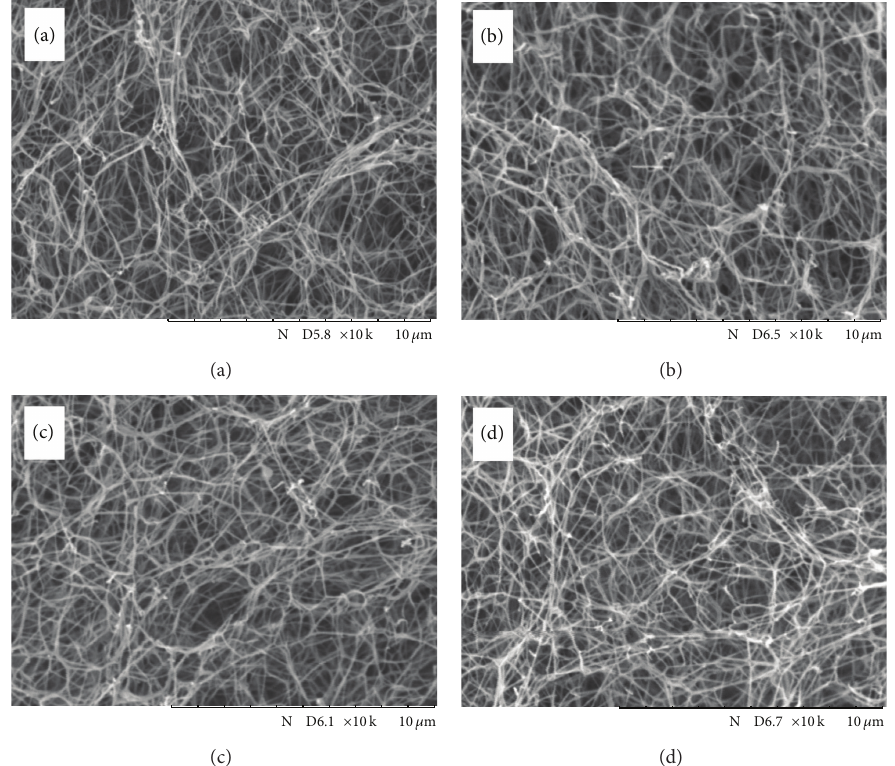
Figure 6: SEM images of cross-sections of dried PSC/genipin gels at genipin concentrations of (a) 0mM, (b) 0.5 mM, (c) 1mM, and (d) 2mM.